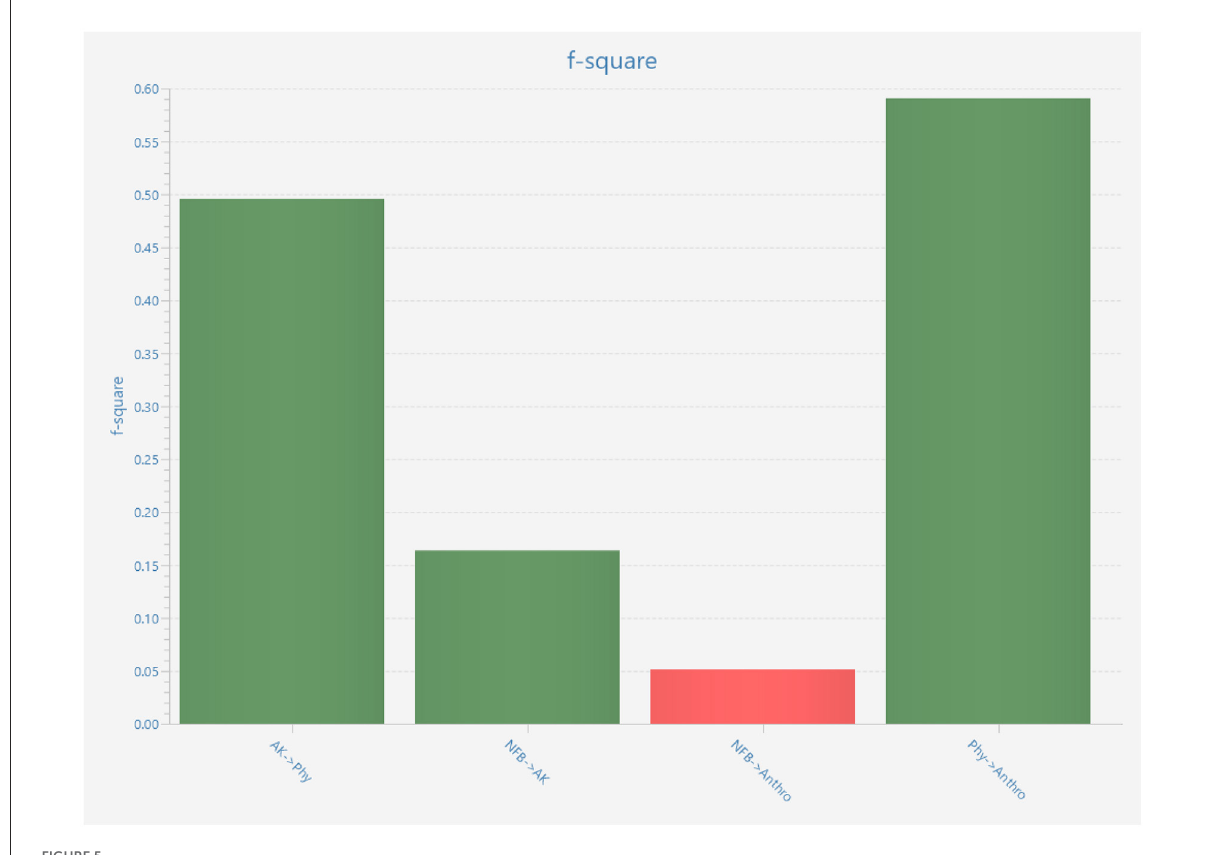
FIGURE5 F -Squared explanatory power.